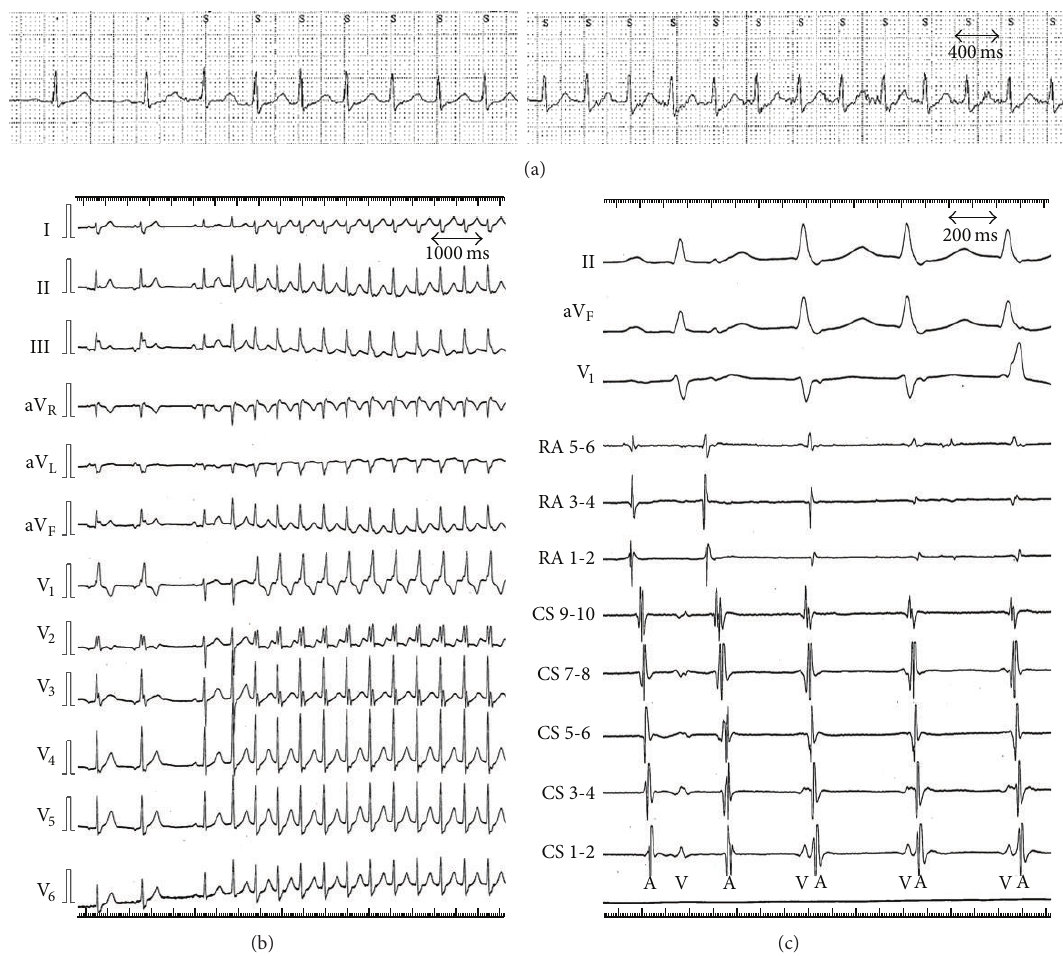
Figure1:(a)Regular170bpmnarrowQRStachycardiadetectedbyHolterelectrocardiography(ECG).(b)12-leadECGofthesupraventricular tachycardia (SVT) (133 bpm) induced by an attachment of electrode catheter tip to the RA wall. 12-lead ECG showed intermittent complete right bundle branch block during both sinus rhythm and SVT. (c) Intracardiac ECG of SVT recorded during the catheter entrapment. SVT was induced with jump up phenomenon. We did not record His bundle electrocardiogram (HBE) to avoid further catheter entrapment. A: atrial electrogram, CS: coronary sinus, RA: right atrium, and V: ventricular